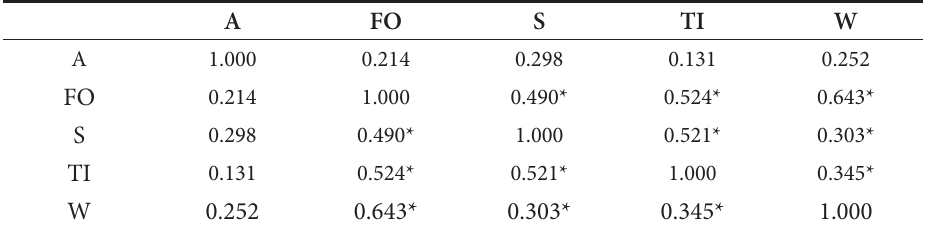
Table 1. Correlation coefficient matrix, independent variables, Garment firms, Myanmar, 2010 A FO S